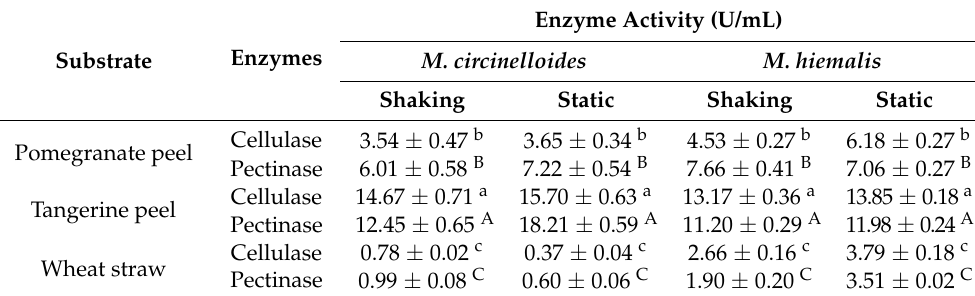
Enzyme Activity